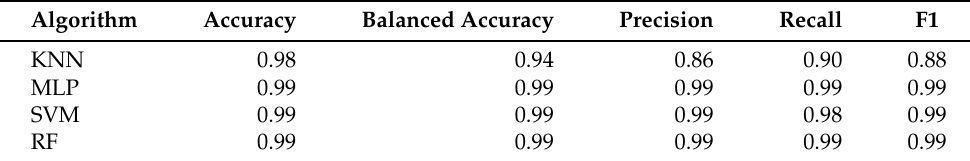
Table 4. Basic Performance Analysis.